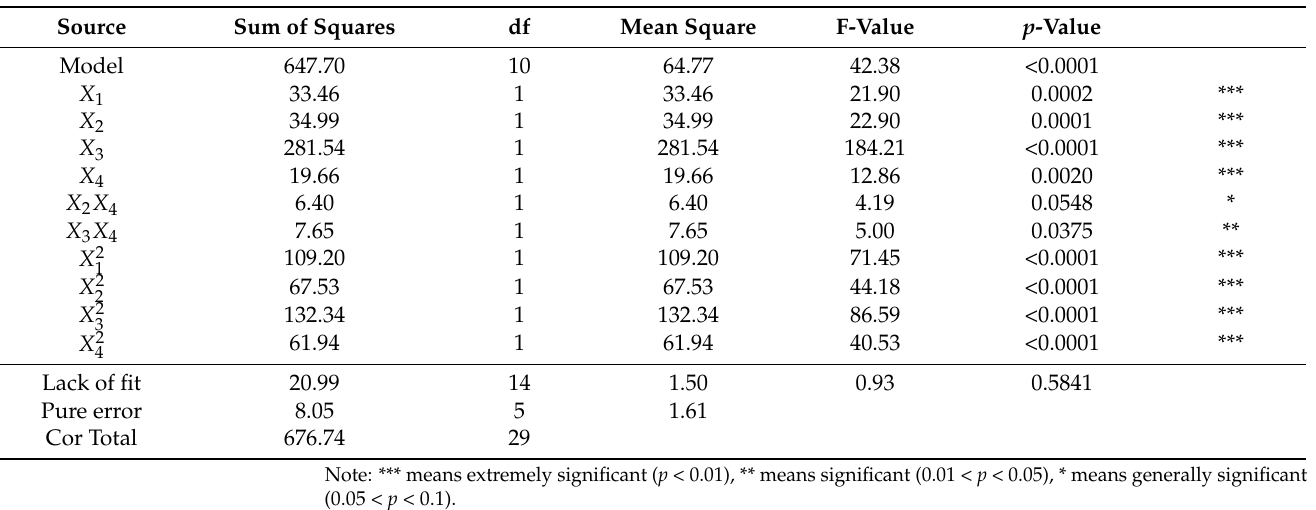
Table 5. Variance analysis of regression equation.